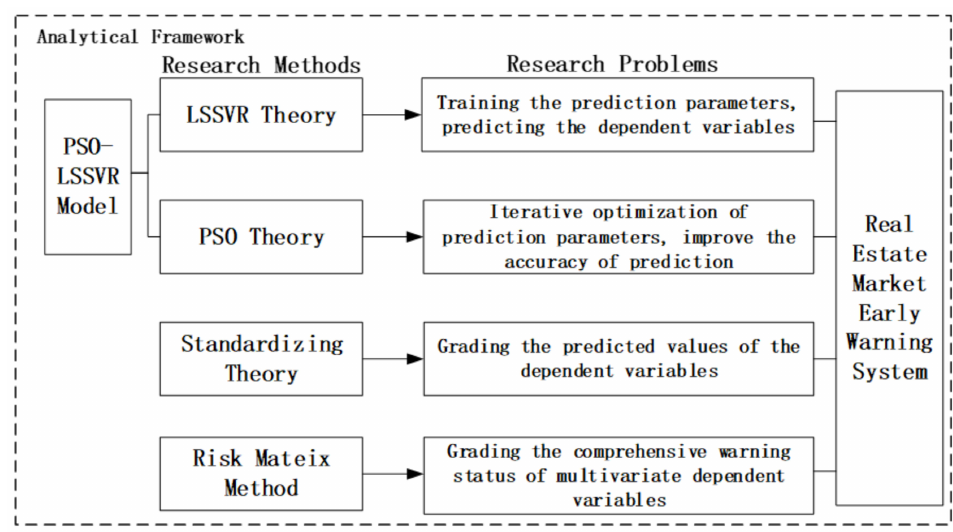
Figure 2. Analytical framework for the research methods and research